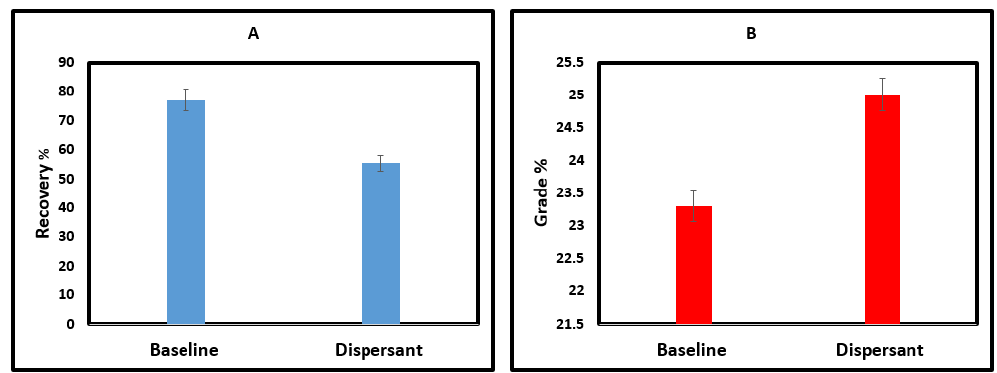
Figure 11. ( A ) Flotation recovery and ( B ) P 2 O 5 grade (%) at different percentages of pulp solids (wt %) in the presence of sodium silicate dispersant.